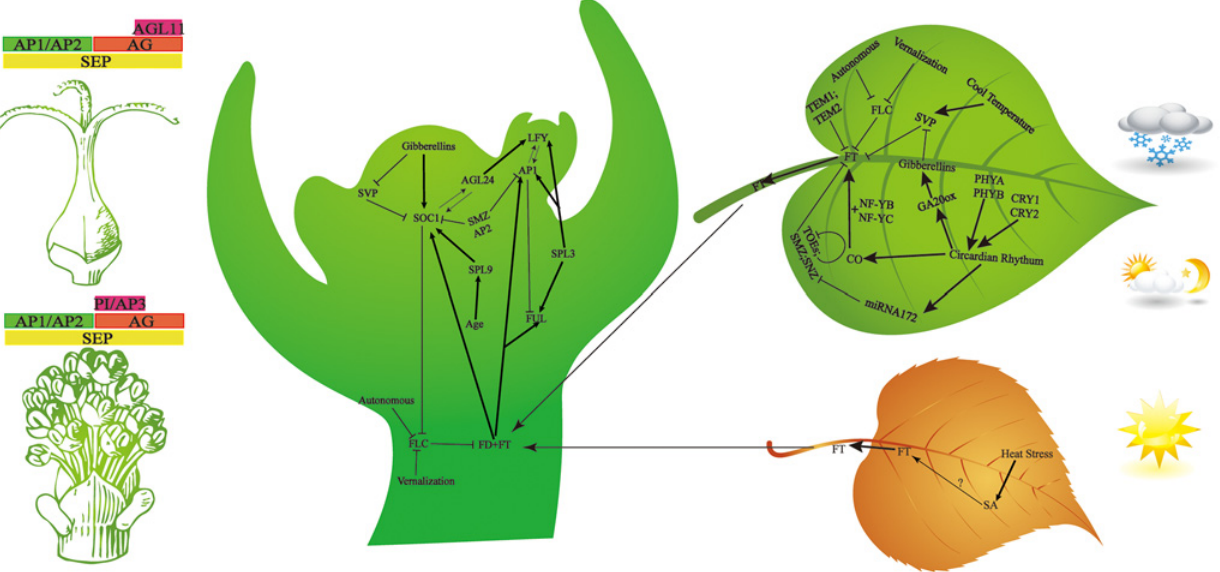
Fig 6. Putative pathway of flower development in S. sebiferum . External (vernalization, photoperiod) and internal (autonomous, age, gibberellins) signals integrate into elaborate genetic network to regulate flowering. The genes components of the genetic network have been discussed in text.